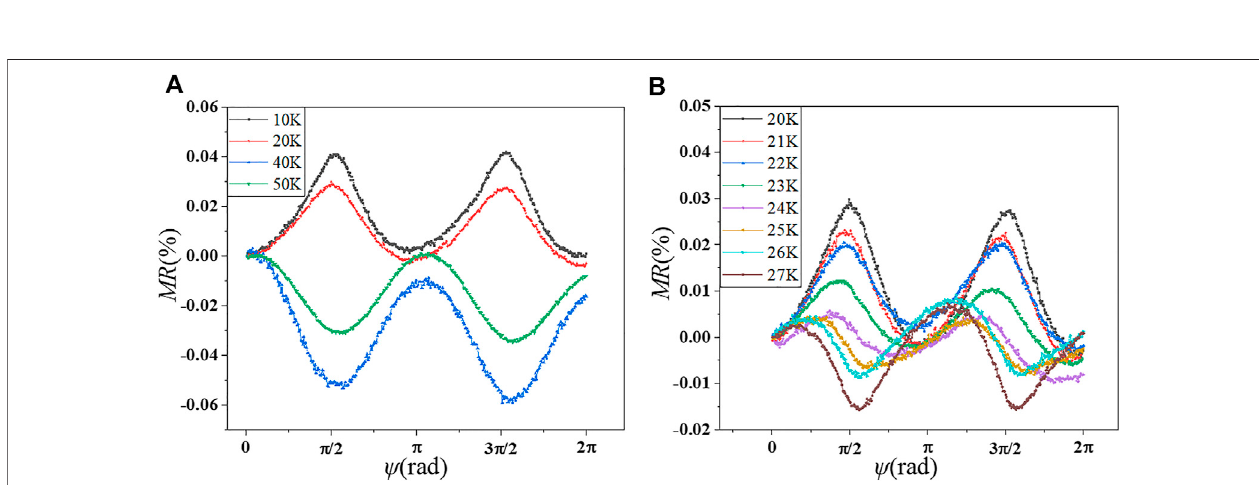
FIGURE 4 | (A) In-plane AMR at different temperatures: 10, 20, 40, and 50 K. (B) In-plane AMR between 20 and 27 K.